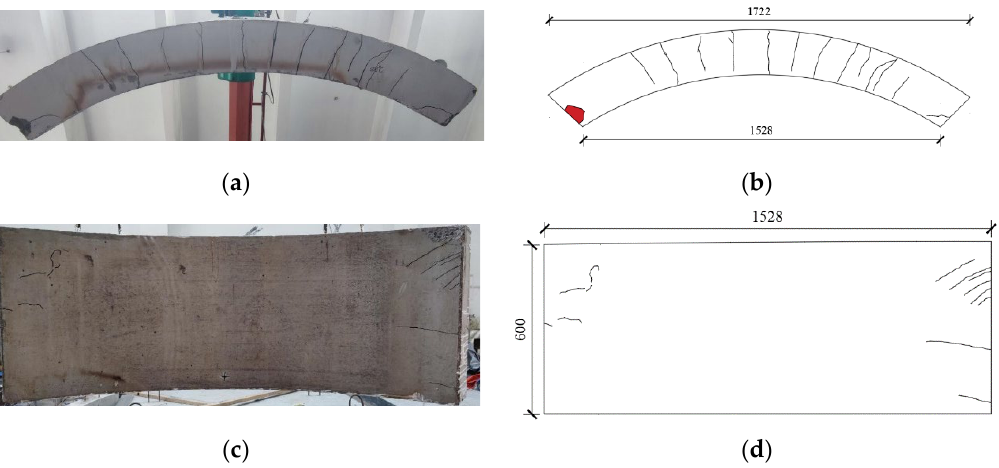
Figure 7. Failure modes of Segment RC—1: ( a ) Cracking pattern; ( b ) Crack pattern on the side surface; ( c ) Bottom surface; and ( d ) Cracking pattern on the bottom surface.